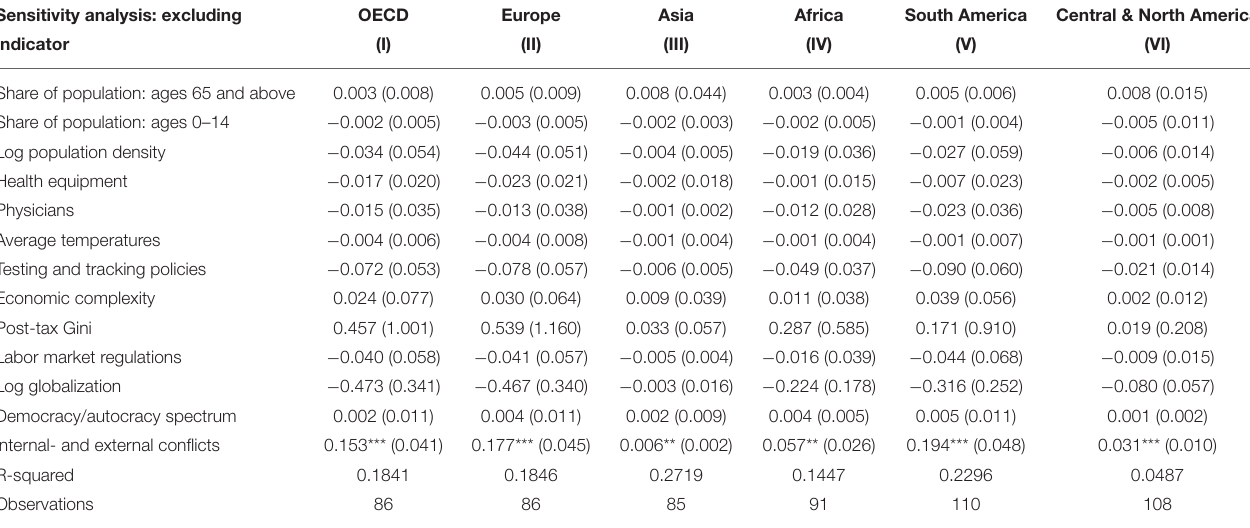
TABLE 3 | Sensitivity analyses of the KRLS